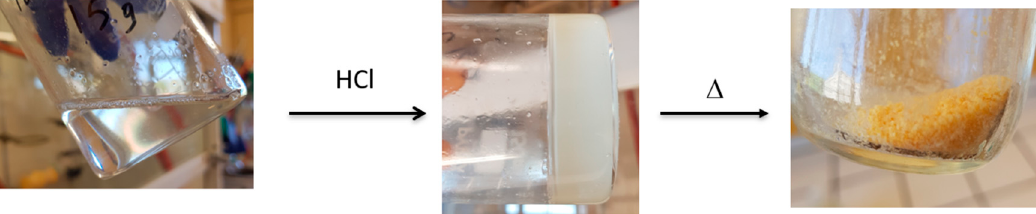
Figure 4. Sol–gel transformation of poly(VDF- ter -VTEOS- ter -VDMP) terpolymer ( P 20 ) in DMF catalyzed by HCl followed by solvent removal at 80 °C under 20 × 10 − 3 bar to produce a crosslinked polymer ( CP 20 ).